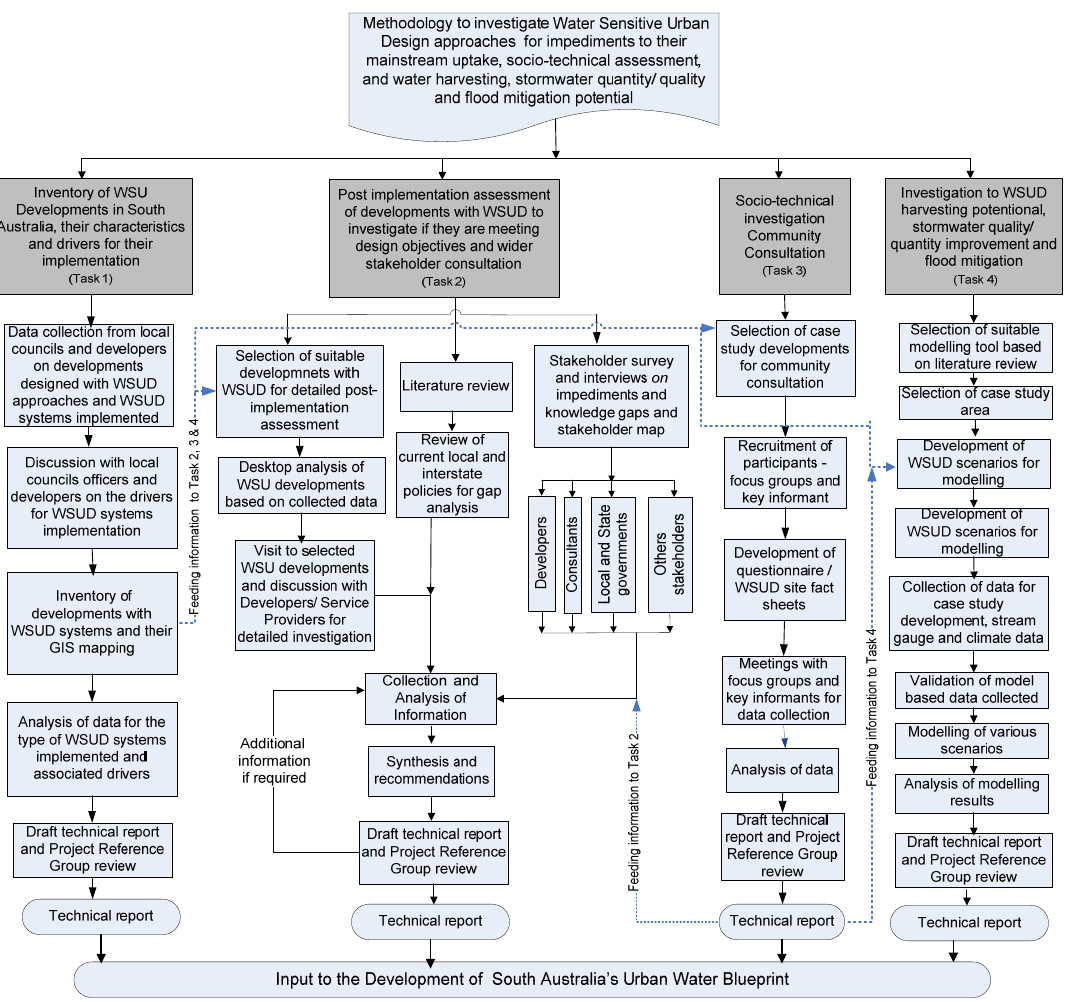
Figure 1. Flow diagram of the methodology adopted for investigation.